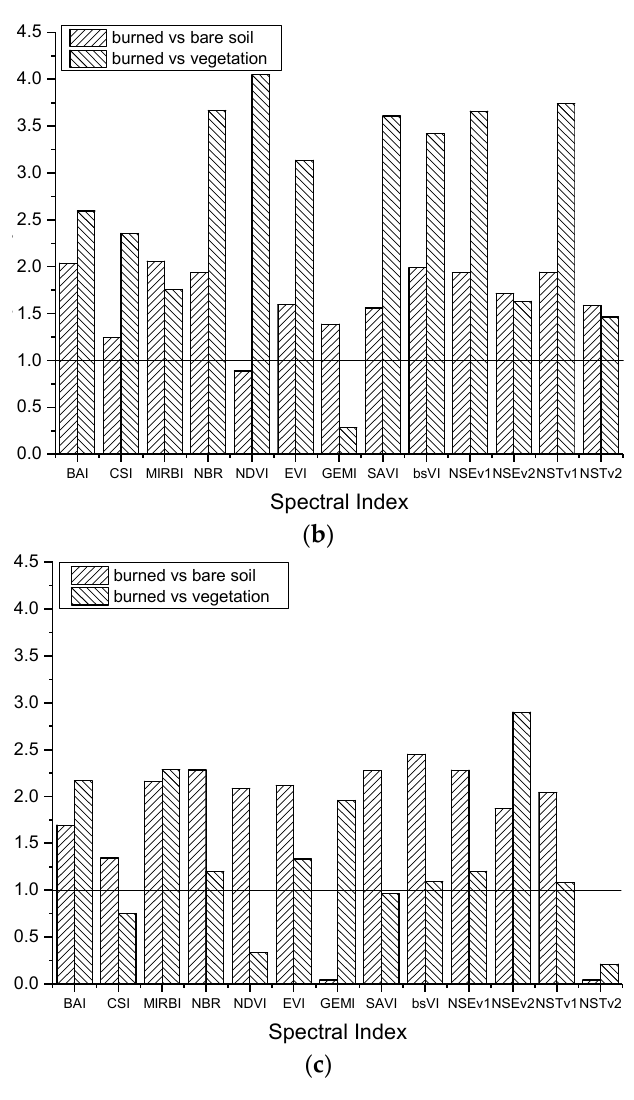
Figure 8. Separability index M of each spectral index on the comparisons between burned area and unburned types: ( a ) M results of Hot Pot Fire; ( b ) M results of Range 12 Fire; ( c ) M results of Rey Fire.